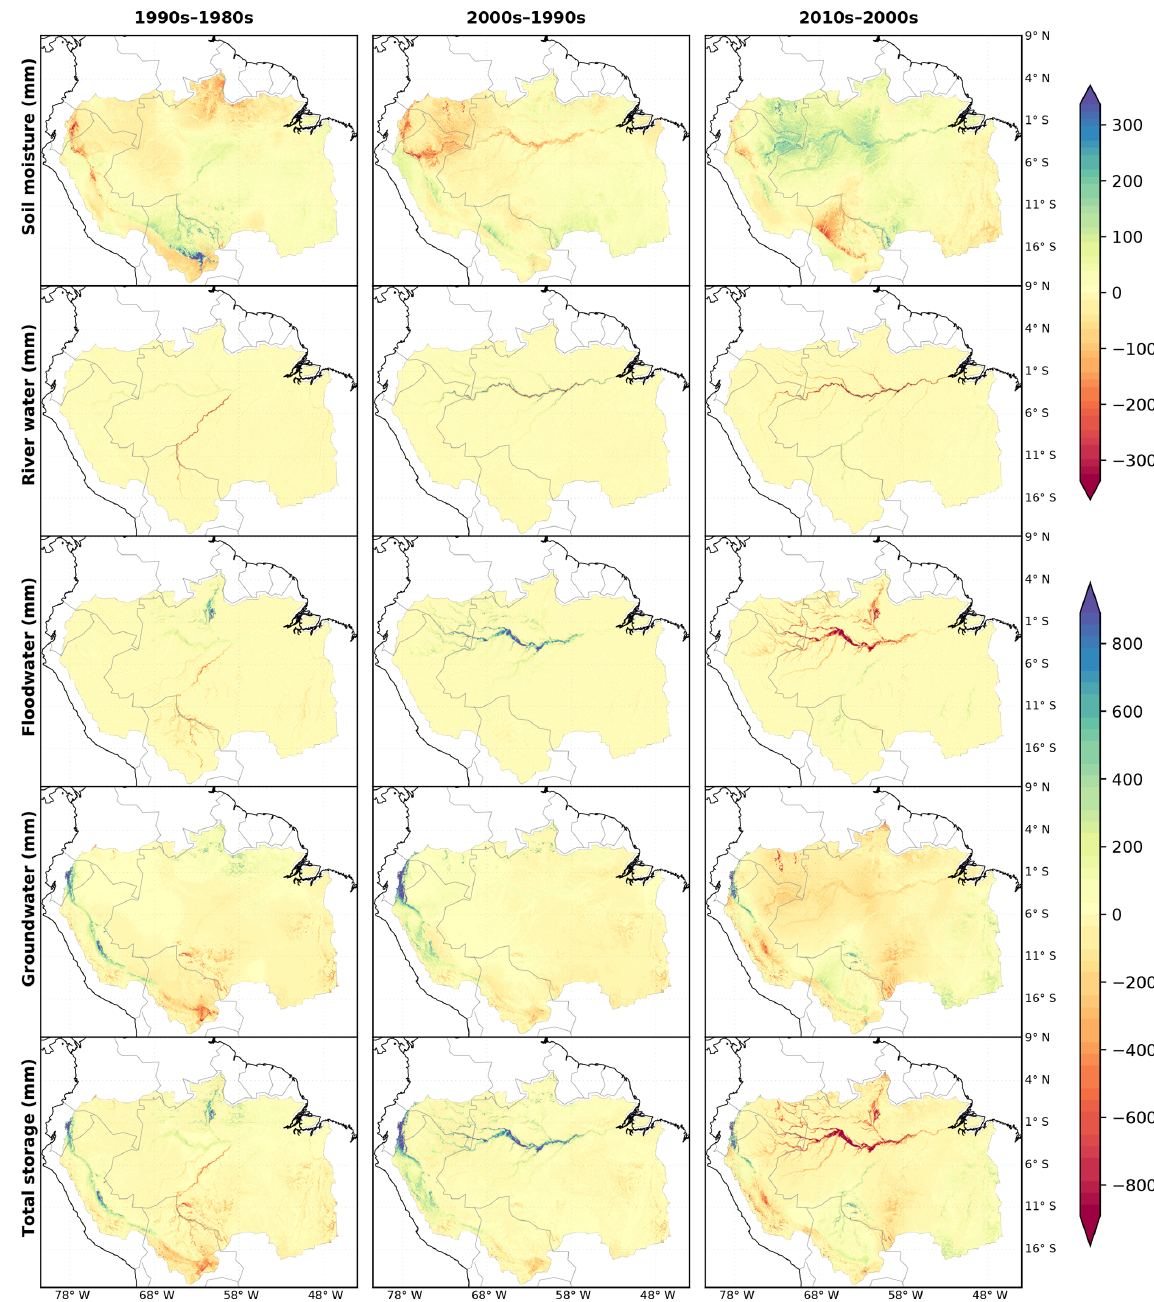
Figure 5. Interdecadal difference between individual water store and TWS storage for the period of 1980–2015 at the original ∼ 2km model grids. The changes are displayed as the difference between consecutive decadal means for TWS and its components. Decadal windows are 1980–1989 as 1980s, 1990–1999 as 1990s, 2000–2009 as 2000s, and 2010–2015 as 2010s. Note that the 2010s period consists of only six years, and the ranges of color bars differ among the